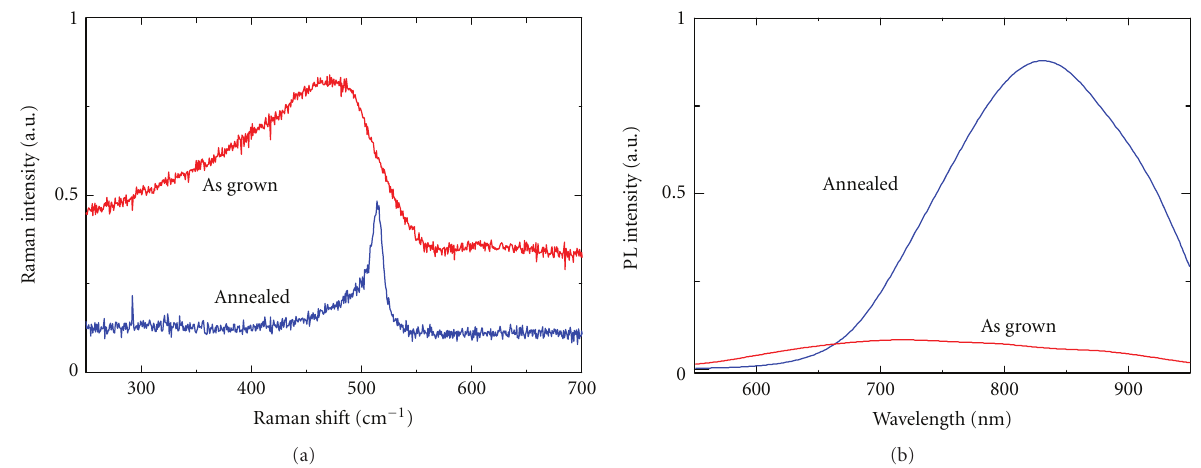
Figure 5: Raman (a) and PL (b) spectra of as grown and annealed at 1100 ◦ C SiO x ( x = 1 . 7) films